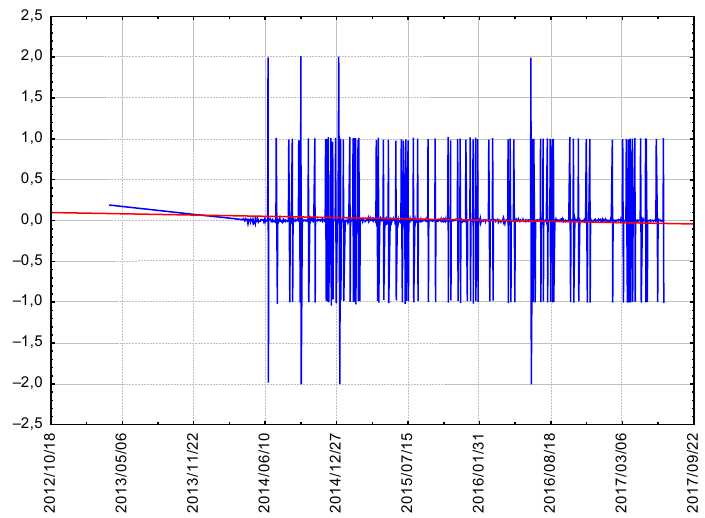
Figure 1. The return of the crude oil WTI futures over the period